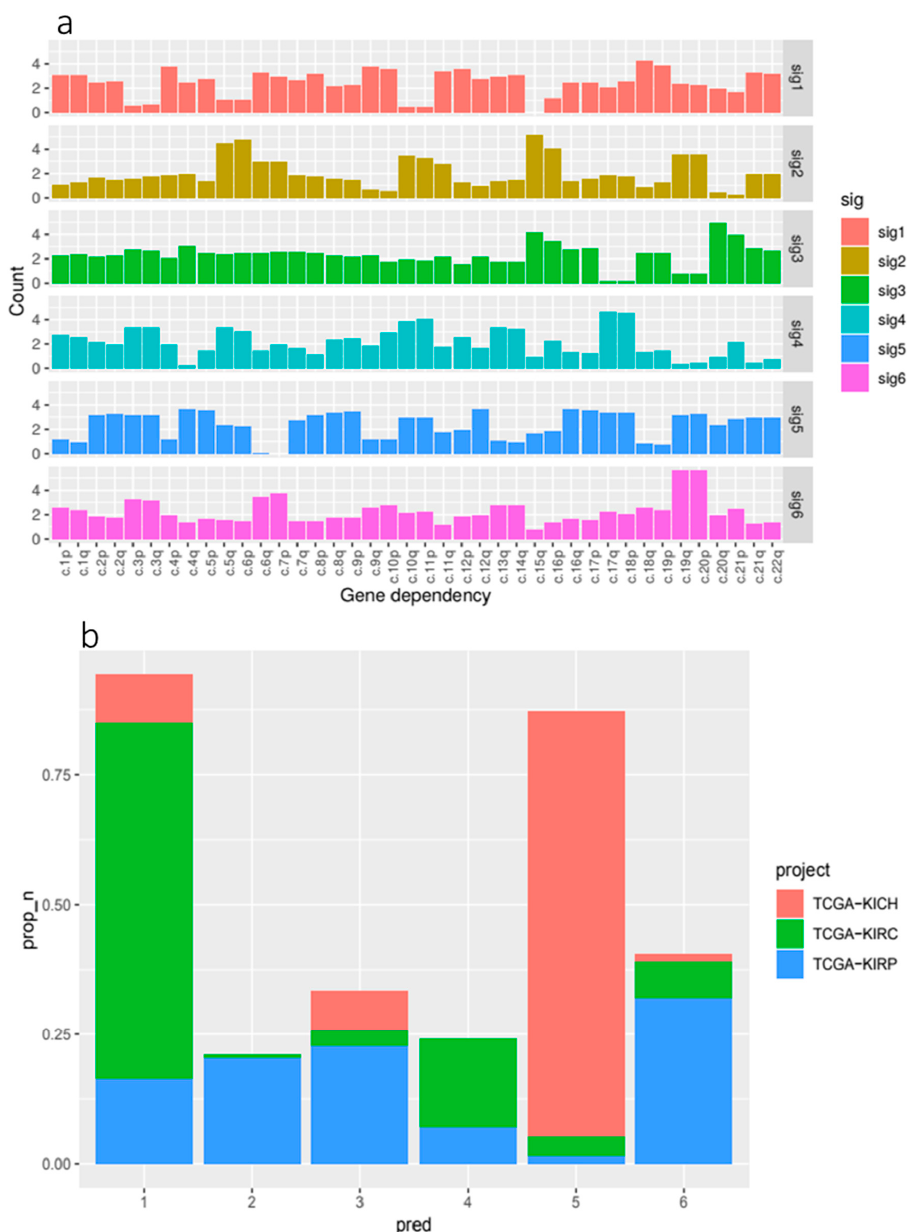
Figure 4. ( a ) Copy number signature composition. A breakdown of the features that describe each